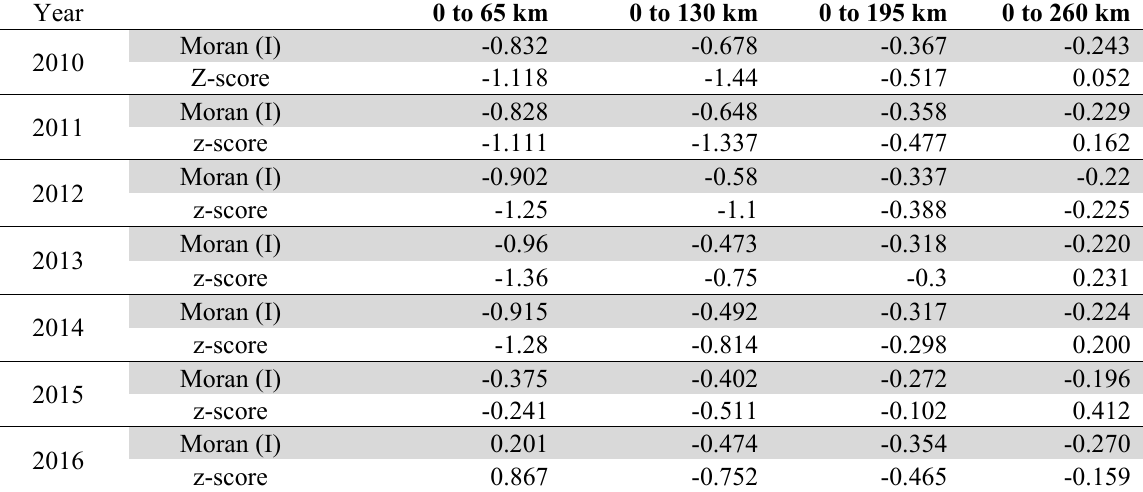
Moran index (I) in the Central Key Economic Zone calculated according to